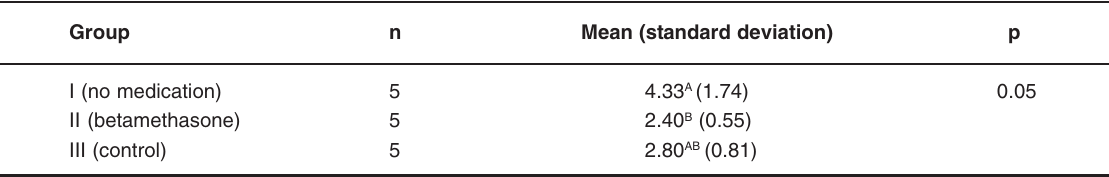
TABLE 1- Mean number of blood vessels per 100 µm 2 recorded in the groups